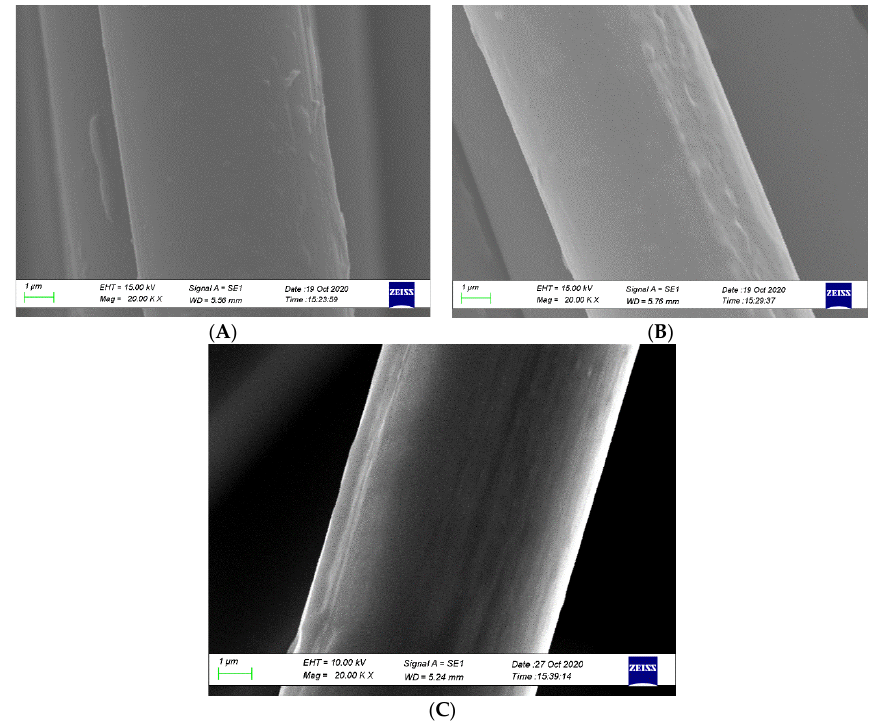
Figure 20. The surface roughness of treated carbon fibres: ( A ) VTMS treatment, ( B ) APTS treatment and ( C ) liquid nitrogen treatment.